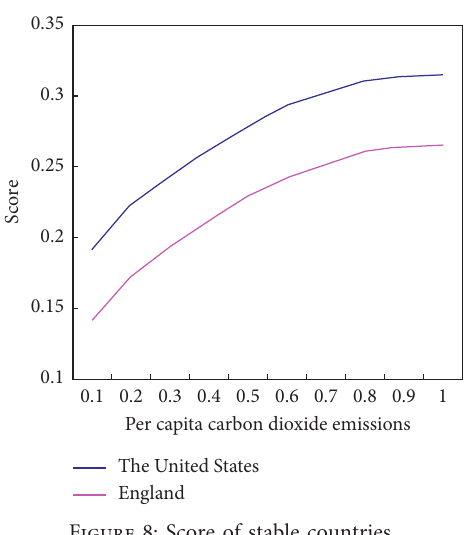
Figure 8: Score of stable